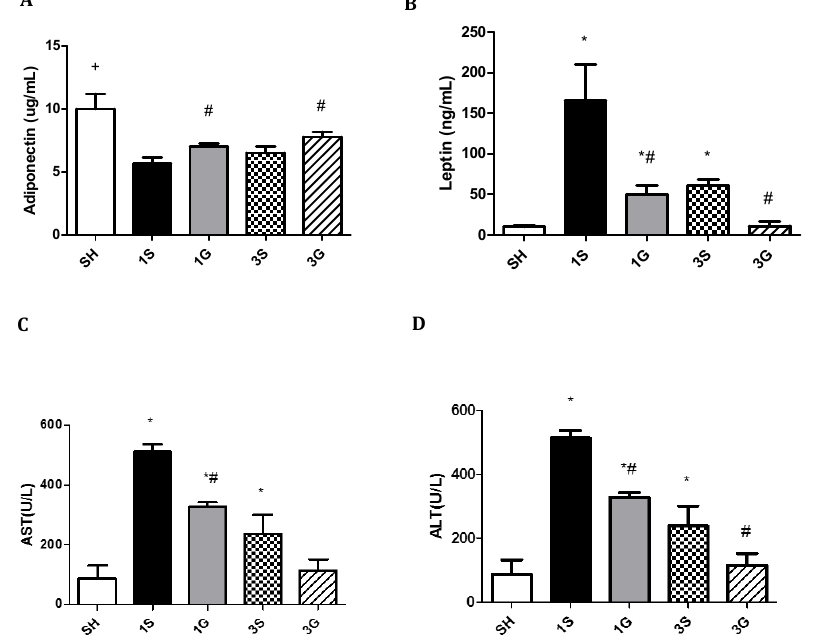
Figure 1. Plasma levels of ( A ) adiponectin, ( B ) leptin, ( C ) AST and ( D ) ALT among the sham group and experimental groups on days 1 and 3 after a sleeve gastrectomy. Data are presented as the mean ± SEM. AST, aspartate aminotransferase; ALT, alanine aminotransferase. SH, sham group; 1S, saline-injected group sacrificed 1 day after the gastrectomy; 1G, GLN-injected group sacrificed 1 day after the gastrectomy; 3S, saline group sacrificed 3 days after the gastrectomy; 3G, GLN-injected group sacrificed 3 days after the gastrectomy. n = 8 for each group. Differences among groups were analyzed by a one-way analysis of variance (ANOVA) followed by the Bonferroni post-hoc test. + Significantly differs from the gastrectomy groups. * Significantly differs from the SH group. # Significantly differs from the S group at the same time point ( p < 0.05).